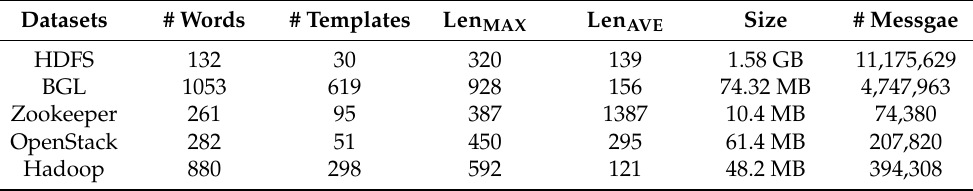
Table 2. Basic information of the test datasets used in Table